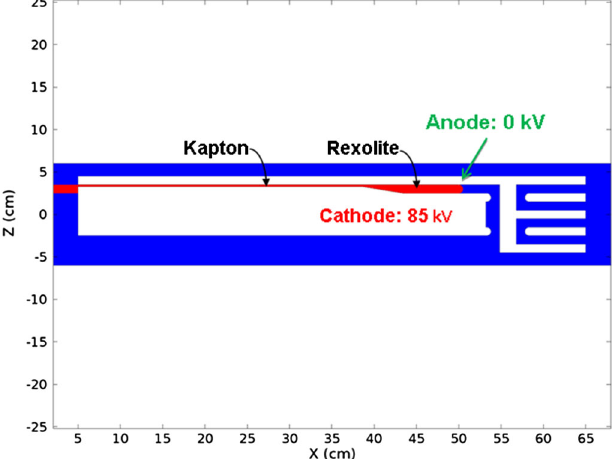
FIG. 8. Cutaway view of DPHC structure in calculation of electric fields. Shown are the boundary voltage values used for the electric field calculations.